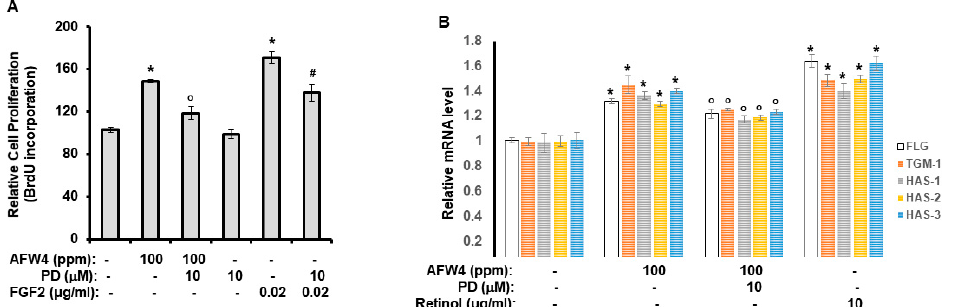
Figure 6. PD98059 attenuates AFW4 effects on the cell proliferation and expression of NMF-related genes. ( A ) HaCaT cells were incubated with AFW4 in the presence of PD98059 (PD) for 48 h. After the incubation, cell proliferation was measured using BrdU cell proliferation assay. Fibroblast growth factor 2 (FGF2) was used as a control compound. ( B ) HaCaT cells were incubated with AFW4 in the presence of PD for 48 h. After the period, the cells were harvested and subjected to real-time RT-PCR analysis. Retinol was used as a control compound. All data are presented as the mean ± SEM of four independent experiments. The results were confirmed using four independent experiments.